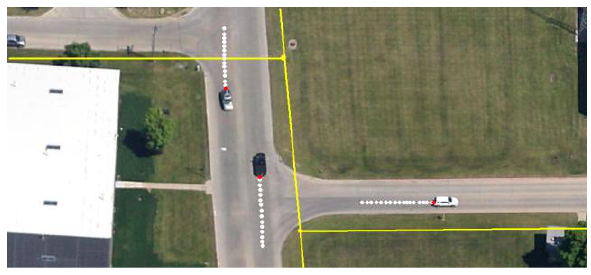
Figure １ : Video frame and map overlay Road networks are a good source of spatial information and can be used for aiding geo-referencing as the network pattern can be exploited for performing local localization. This local information can be used to refine the approximate global location given by the localization sensors. For this purpose the complete road network need not be extracted but the sparsely located features like road intersections and road segments would be sufficient. These intersections and road segments can aid in correcting the geo-referencing errors by matching these features with the map database. This method works well in urban regions where there is a good amount of traffic flow on the